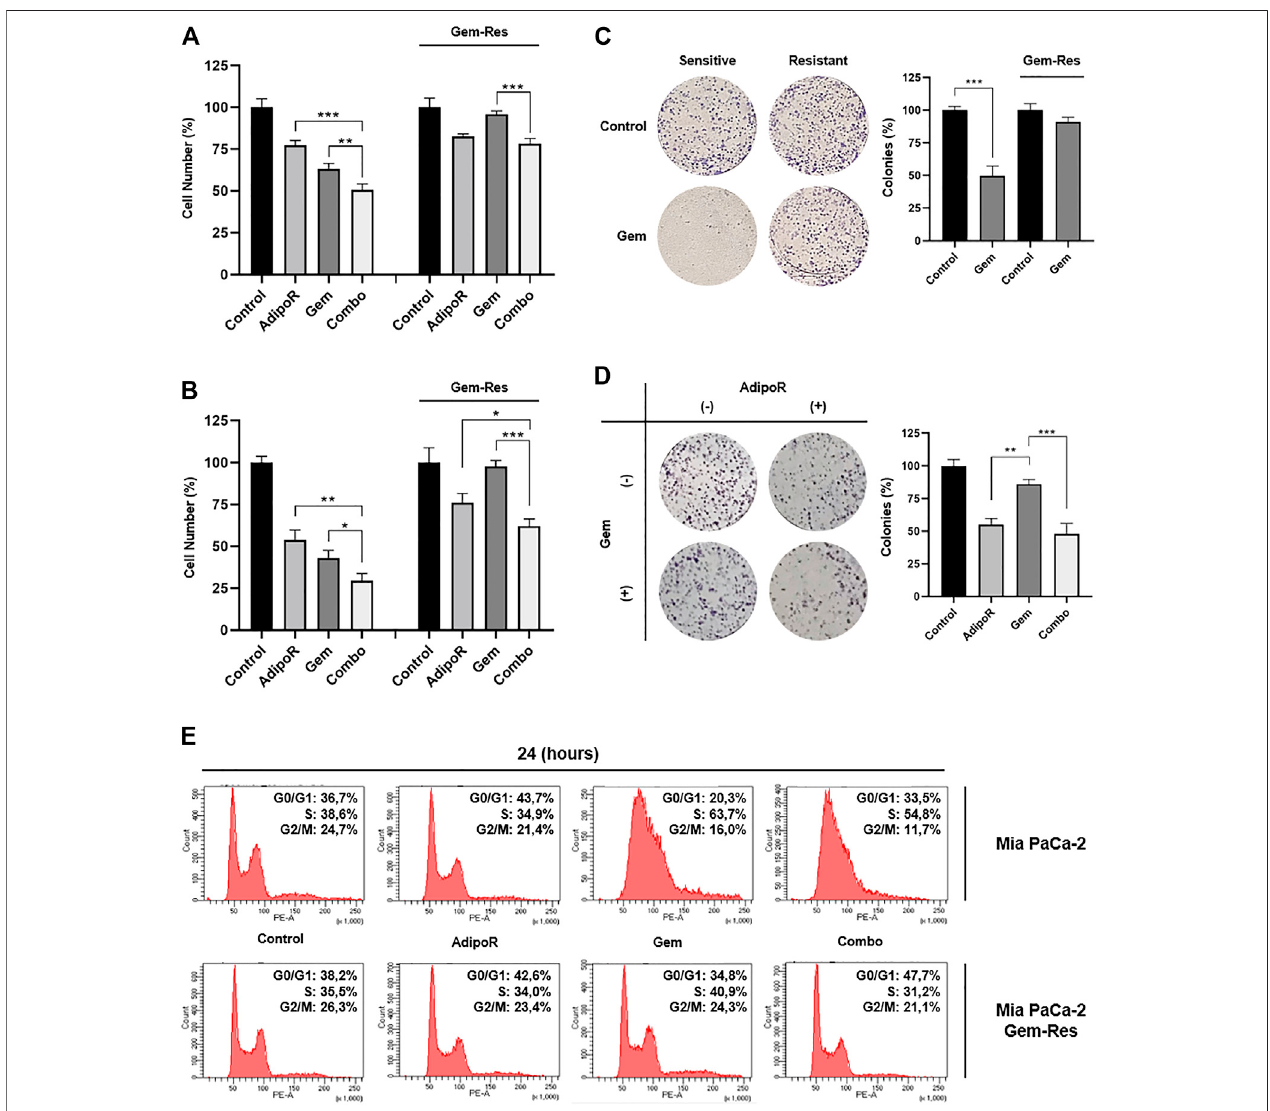
FIGURE6| Responsiveness ofMIAPaCa-2 Gem-resistantcells tosingle and combinatory treatments. Either MIAPaCa-2 Gem-sensitive and -resistantcells were treatedandnot(control)with10 µg/mlAdipoR, 15 nMGem,andAdipoR plusGemfor24 (A) and48 h (B) ;thereafter,therelative impactoncellgrowthwasaddressed. (C) CellmediaofbothMIAPaCa-2Gem-sensitiveand-resistantcellsweresupplementedwithandwithout(control)10 nMGemfor8days.Illustrativeviolet-stainedwells are shown on the left side, the relative quanti fi cation on the right. (D) MIA PaCa-2 Gem-resistant cells undergoing AdipoR (10 µg/ml) and Gem (5 nM) individually andcombinatorytreatmentsweretestedforcolony-formingability.Imagesandquanti fi cationassayareprovidedinFigure. (E) MIAPaCa-2Gem-sensitiveand-resistant were incubated either with single or combination drugs as indicated in (A) . FACSCelesta TM analysis was later performed with the purpose of de fi ning the